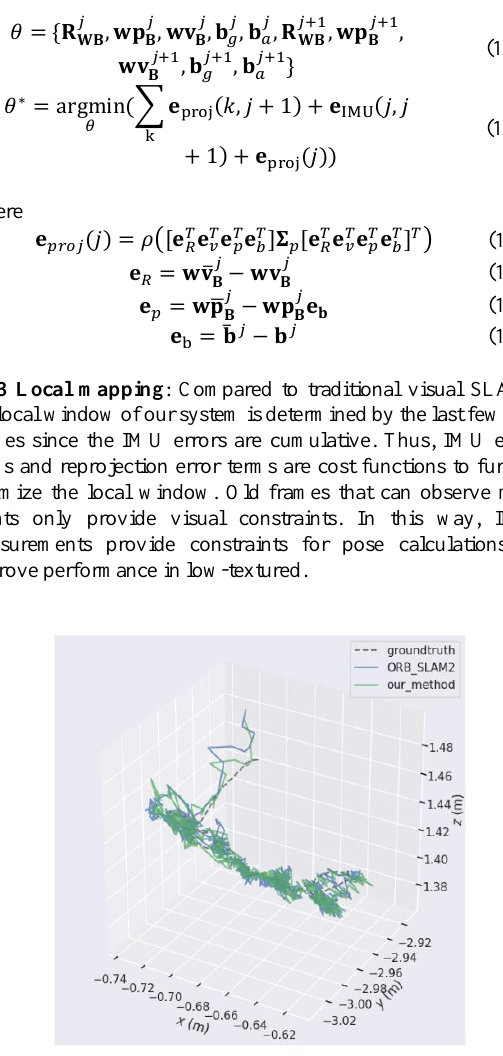
Figure 6. Trajectory graph of fr3_sitting_static predicted by ORB SLAM2 and our system.